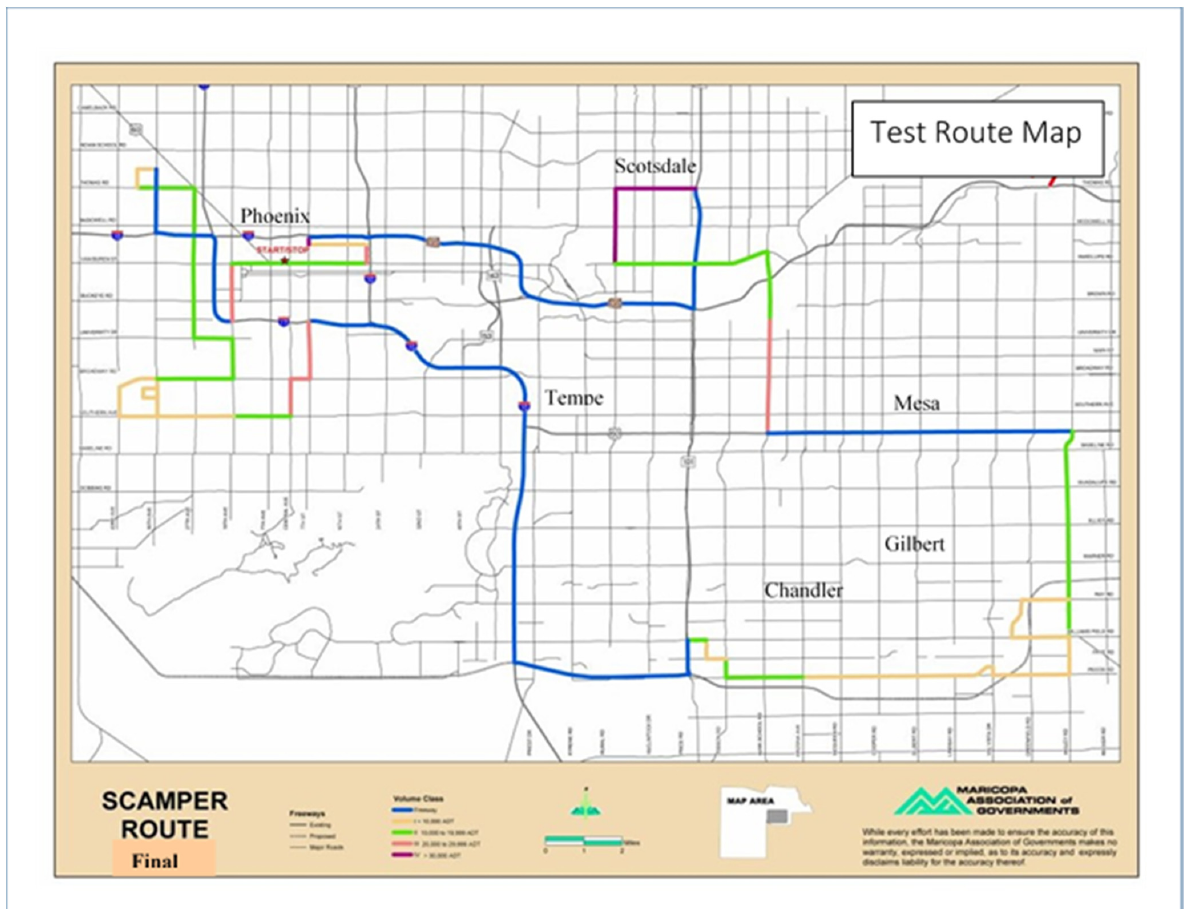
Figure 1. Map of the test route.